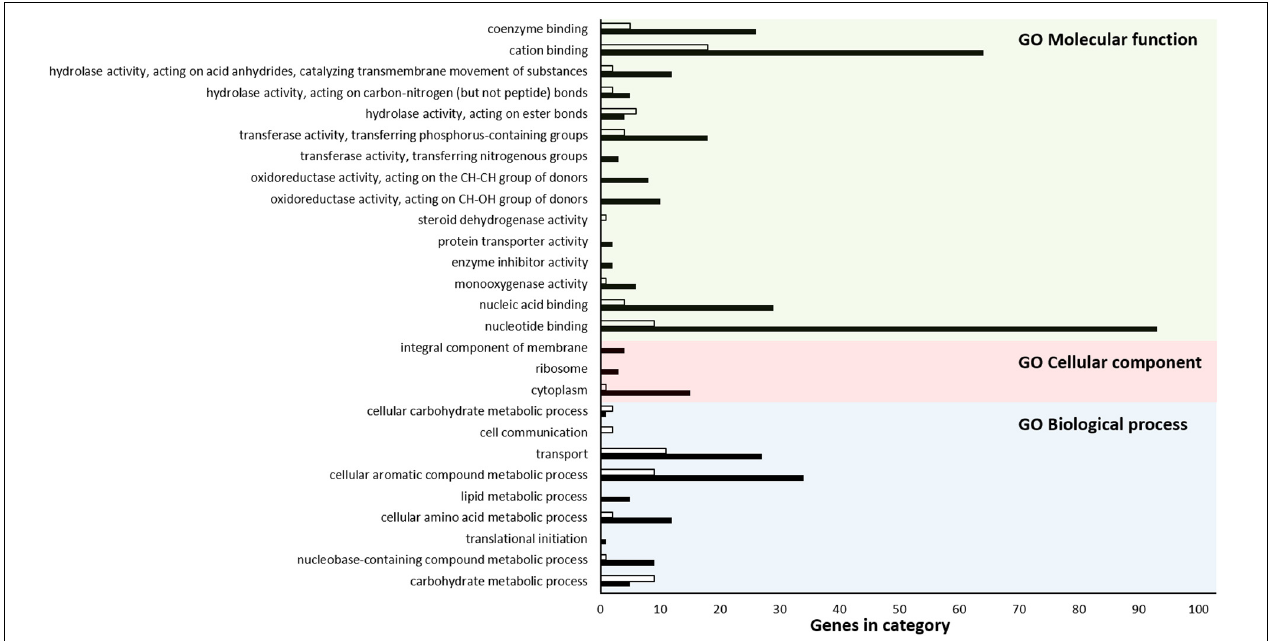
FIGURE 3 | GO functional annotation histogram of DEGs. The GO term for each bar is indicated under the x -axis. The y -axis represents GO terms. Black and white colors represent the numbers of up- and down-regulated DEGs, respectively. The x -axis represents the number of genes showing differential expression. Three classifications based on the GO annotation categories of biological process, cellular component, and molecular function are denoted at the top of the bars as BP, CC, and MF,